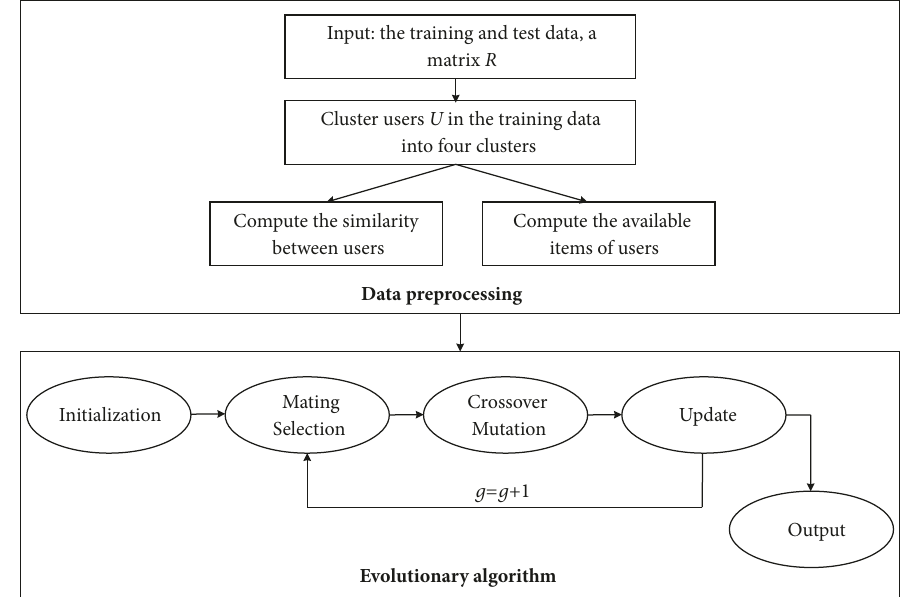
Figure 4: Flowchart for MOEA-EPG.